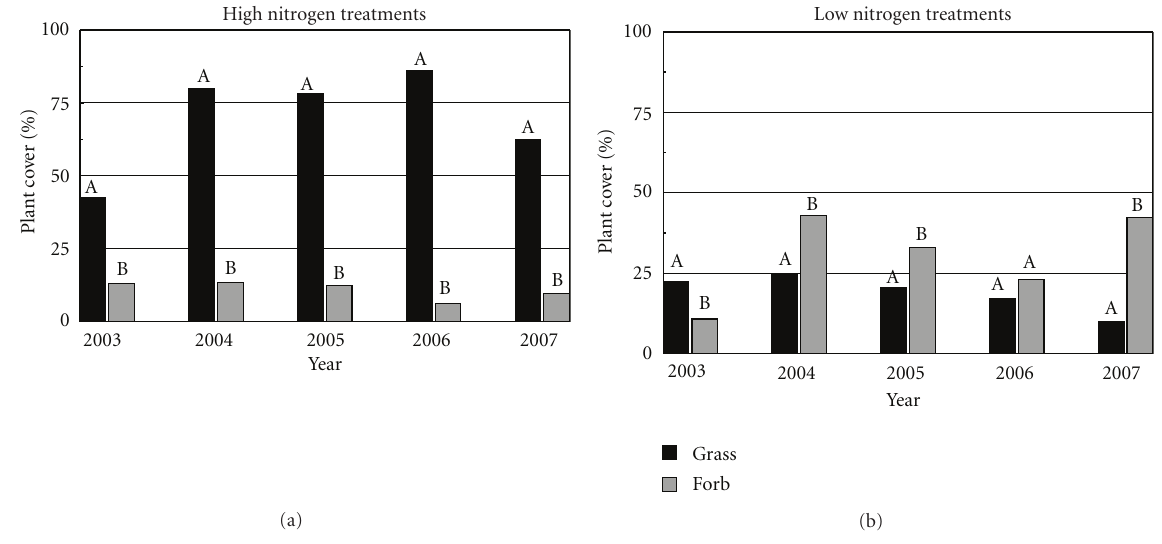
Figure 5: Mean vegetation response in (a) pooled high nitrogen treatments and (b) pooled low nitrogen treatments by year. Responses associated with di ff erent letters are significantly di ff erent ( P < 0 .